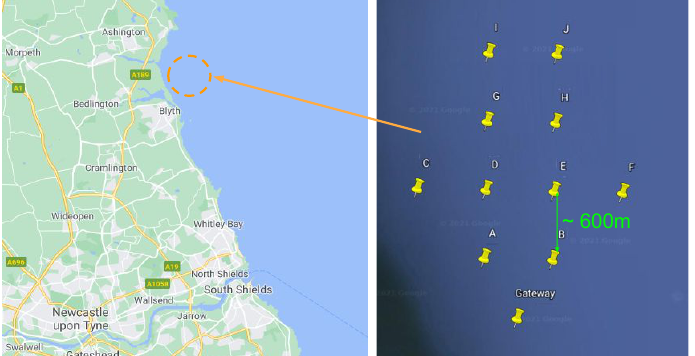
Figure 17. Long-term North Sea deployment setup. Ten sensor nodes and one gateway were deployed off the coast of Blyth in the North of England 10m above the sea bed in 20m to 30m water depths. The gateway node was located on the edge of the network to provide longer end-to-end dual-hop links with the sensor